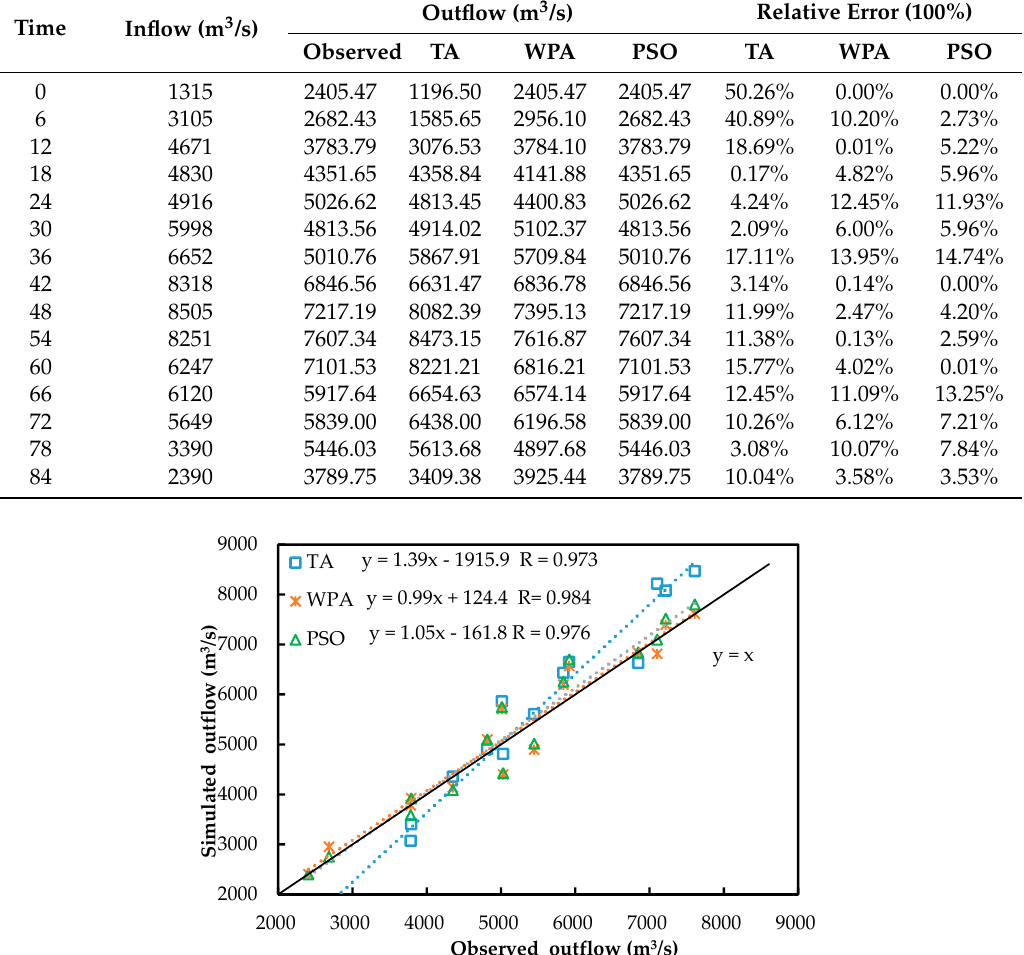
Table 7. 20140909 flood simulation of Ankang Power Station to Shuhe Power Station.